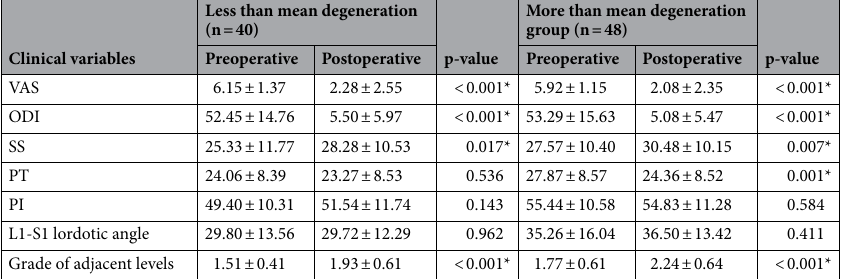
Table 3. Preoperative and postoperative clinical characteristics stratified by mean degeneration score. The data were expressed as mean ± standard deviation. Statistical differences were examined by paired t-test. *indicated statistical